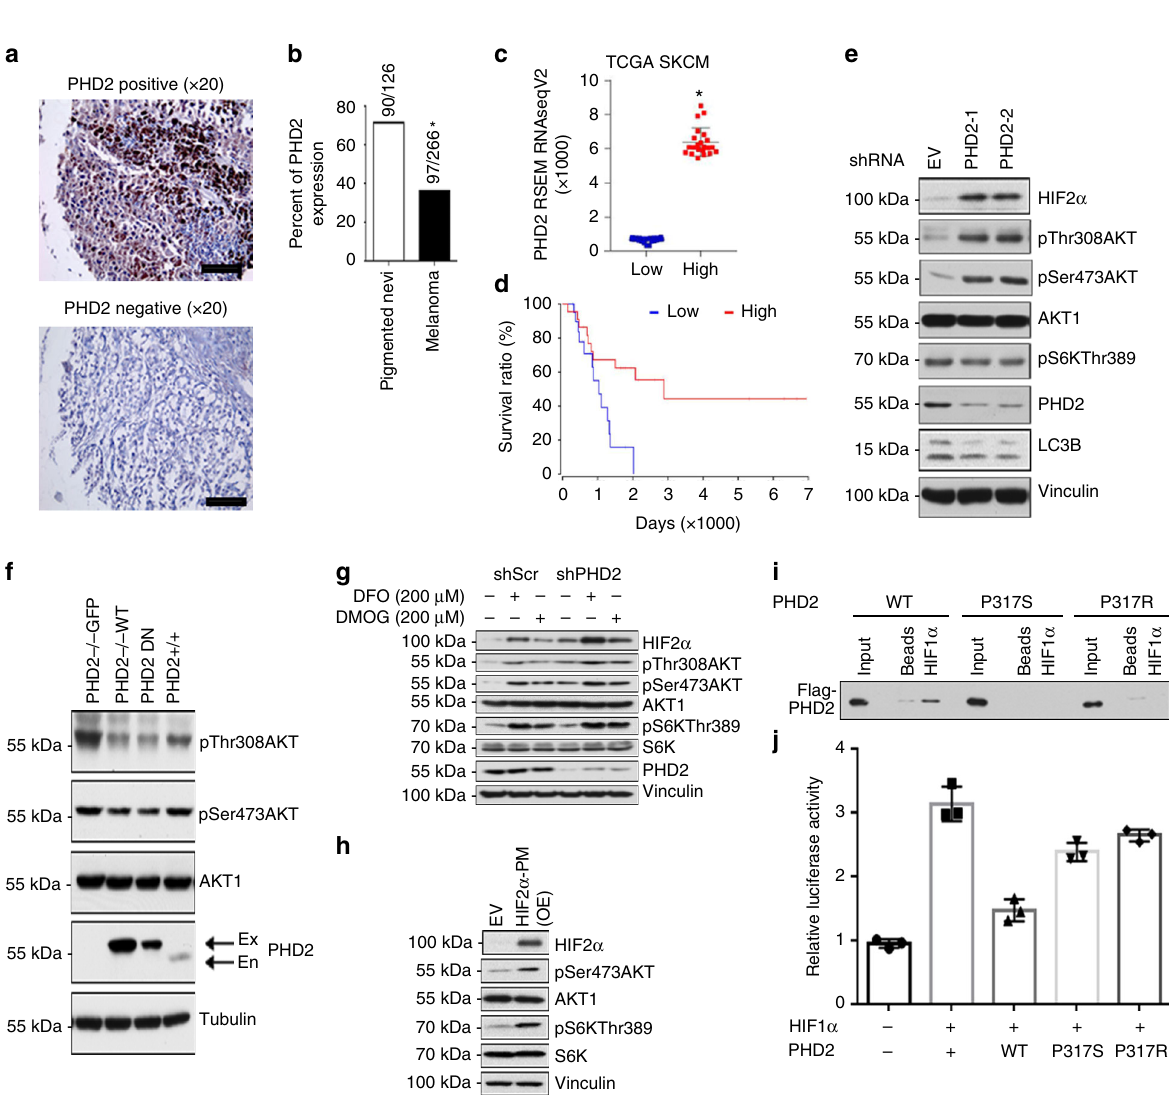
Fig. 1 PHD2 expression and function in human melanocytes and melanomas. a IHC staining of PHD2 in 126 nevus and 266 melanoma specimens. A melanoma progression tissue microarray (TMA) was stained with the anti-PHD2 antibody and PHD2 staining positive and negative cases were calculated. Representative PHD2 positive (upper panel) and negative cases (lower panel) are shown. Bars indicate 100 µ m. b Percentage of cases with PHD2 expression. There was signi fi cantly less percentage of melanoma cases with PHD2 expression than that of nevi; *p < 0.01. c . TCGA SKCM patients were sorted into PHD2-high and PHD2-low groups according to PHD2 mRNA expression levels (top 5% versus bottom 5%). d PHD2 expression and survival curve. The Kaplan – Meier survival curves showed that the PHD2 -high group have a signi fi cantly improved patient survival than PHD2 -low group (log rank p value = 0.00643). e PHD2 knockdown induces Akt phosphorylation. Immortalized human melanocytes (hTERT/p53DD/Cdc24R24C-BRAFV600E) were transfected with two independent PHD2 shRNAs. Cells transfected with shGFP were included as a negative control. Western blots were performed using the indicated antibodies. f Reintroduction of PHD2 in PHD2 − / − MEFs reduces Akt phosphorylation. PHD2 − / − MEFs (left lane) were transfected with wild- type PHD2 (lane adjacent to the left lane). PHD2-positive MEFs which express endogenous PHD2 were used as a control (right lane). g DFO or DMOG treatment. Immortalized human melanocytes were transfected with control vectors or EGLN knockdown vectors. These cells were than treated with DFO or DMOG. h Overexpressed HIF-2 α in immortalized human melanocytes. i The melanoma-derived PHD2-P317 mutation inhibits PHD2 binding to HIF-1 α . Biotin-labeled HIF1 α -ODD peptides were incubated with WCLs derived from HEK293T cells transfected with the indicated PHD2 constructs (beads as negative control). Binding of PHD2 to HIF1 α -ODD is abolished with the P317 mutation. j The PHD2-P317 mutation inhibits PHD2 and HIF-1 α interaction. Unlike WT-PHD2, P317S-PHD2 is largely impaired in inhibiting HRE reporter activities detected by the Dual-Luciferase Reporter Assay System. The error bars indicate